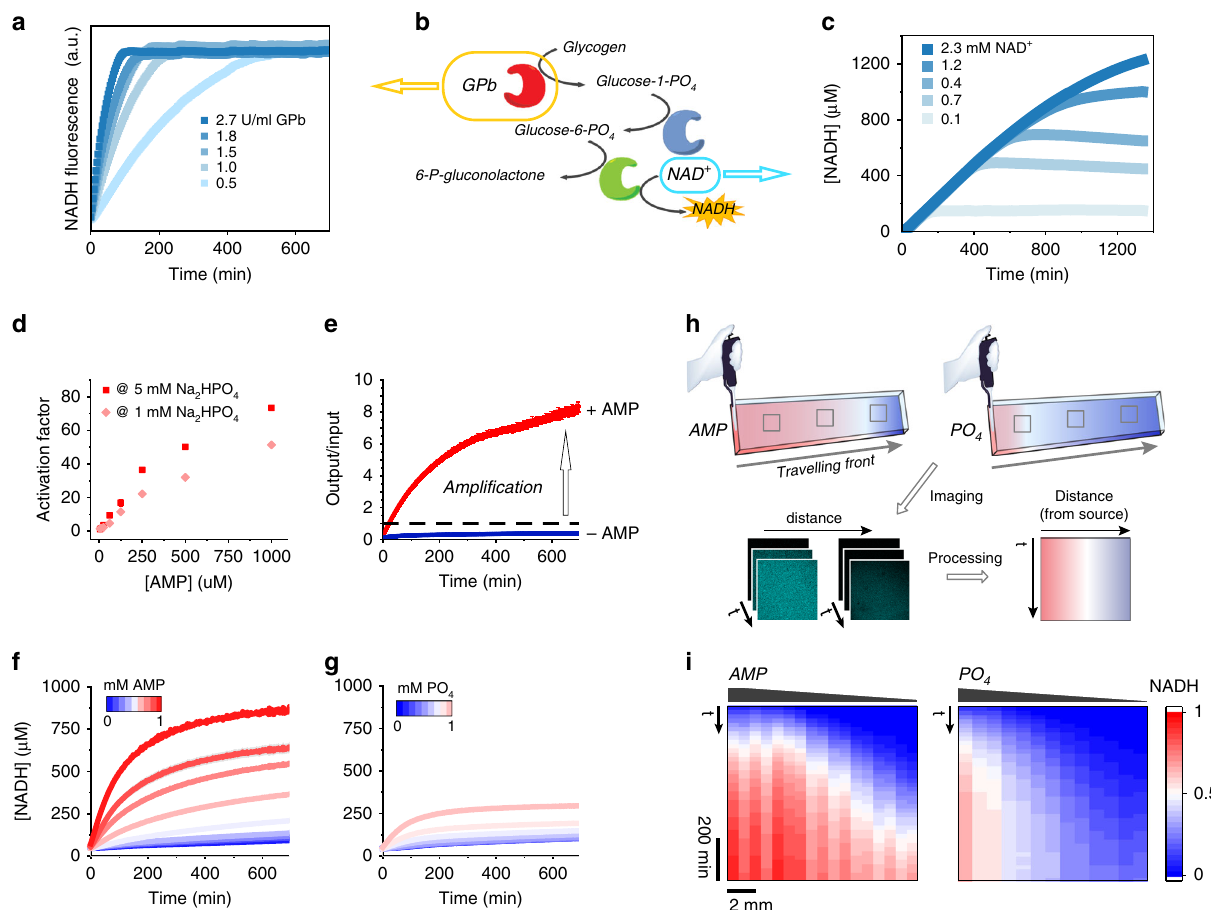
Fig. 2 Ampli fi cation of the AMP signal by activation of a three-enzyme Response Cascade. a – c Tuneable ampli fi cation of the AMP signal by the Response Cascade ( b ): ( a ) the GPb activity (0.5 – 2.7 U ml – 1 ) dictates the kinetics of the output generation; ( c ) the concentration of NAD + (0.1 – 2.3